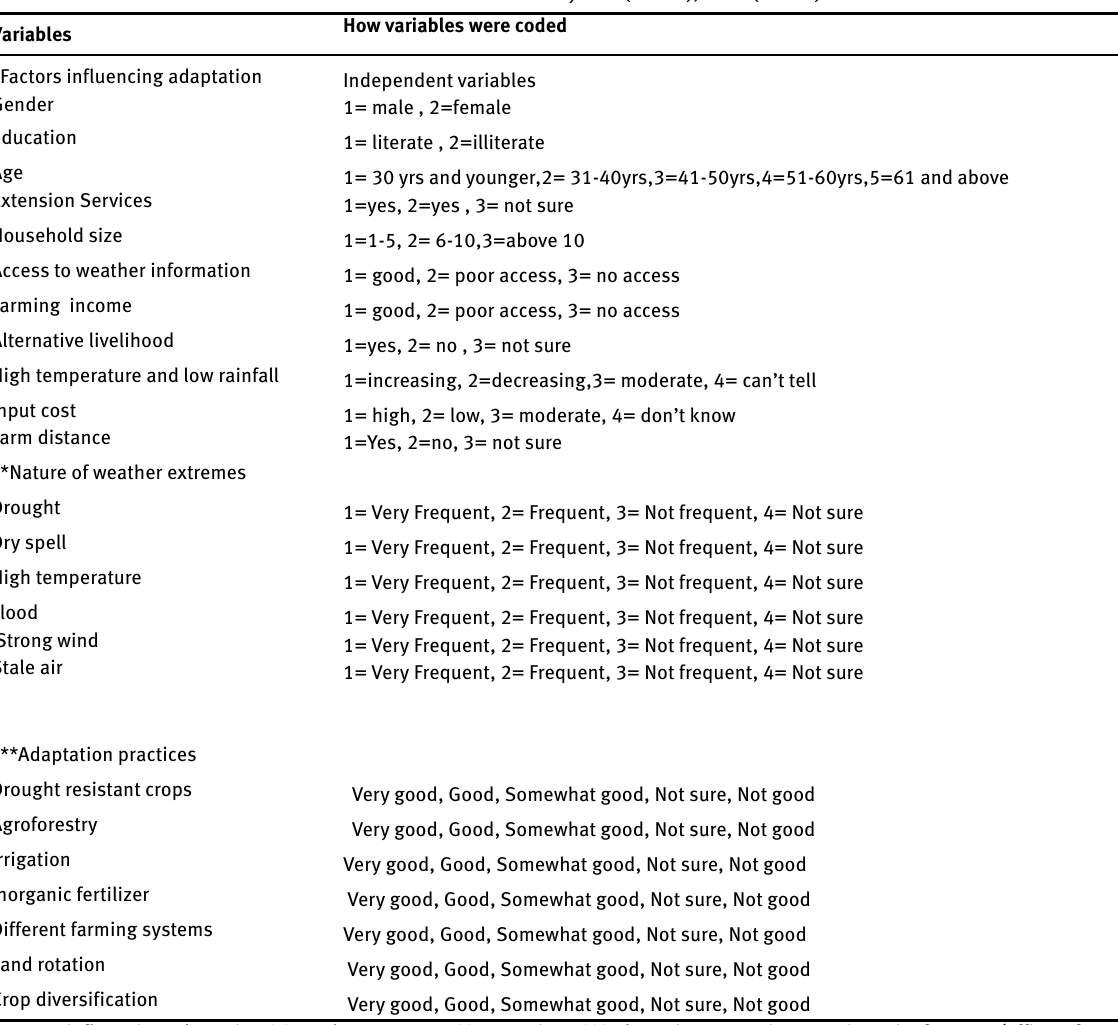
Table 1: Definition of variables used to elicit information in the study area (N=225), FGDs